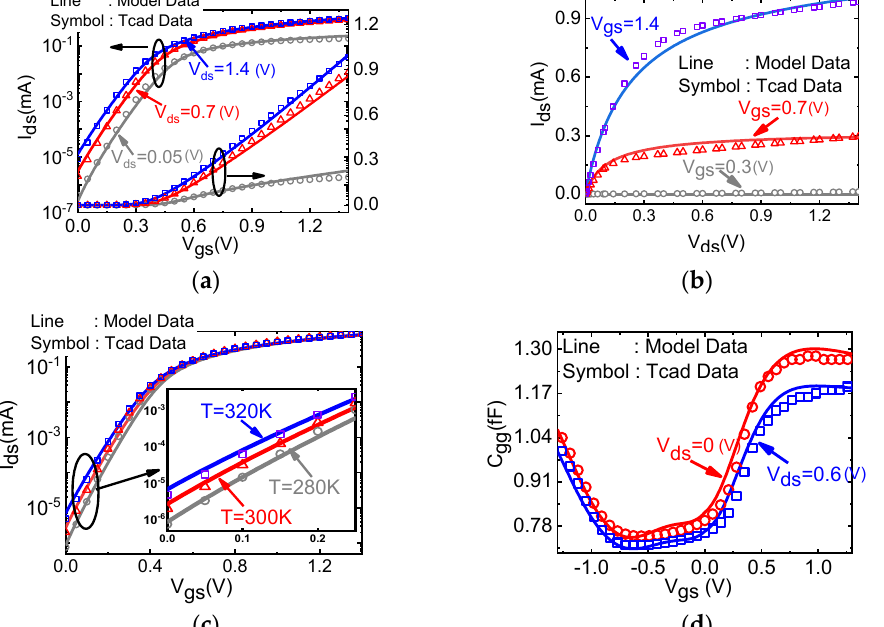
Figure 6. A good match between our MOSFET compact model (line) and the TCAD solution data (symbol) for ( a ) output characteristics, ( b ) transfer (both in conventional and logarithmic coordinates) characteristics, ( c ) transfer characteristics with different temperature, and ( d ) gate capacitance to gate voltage.